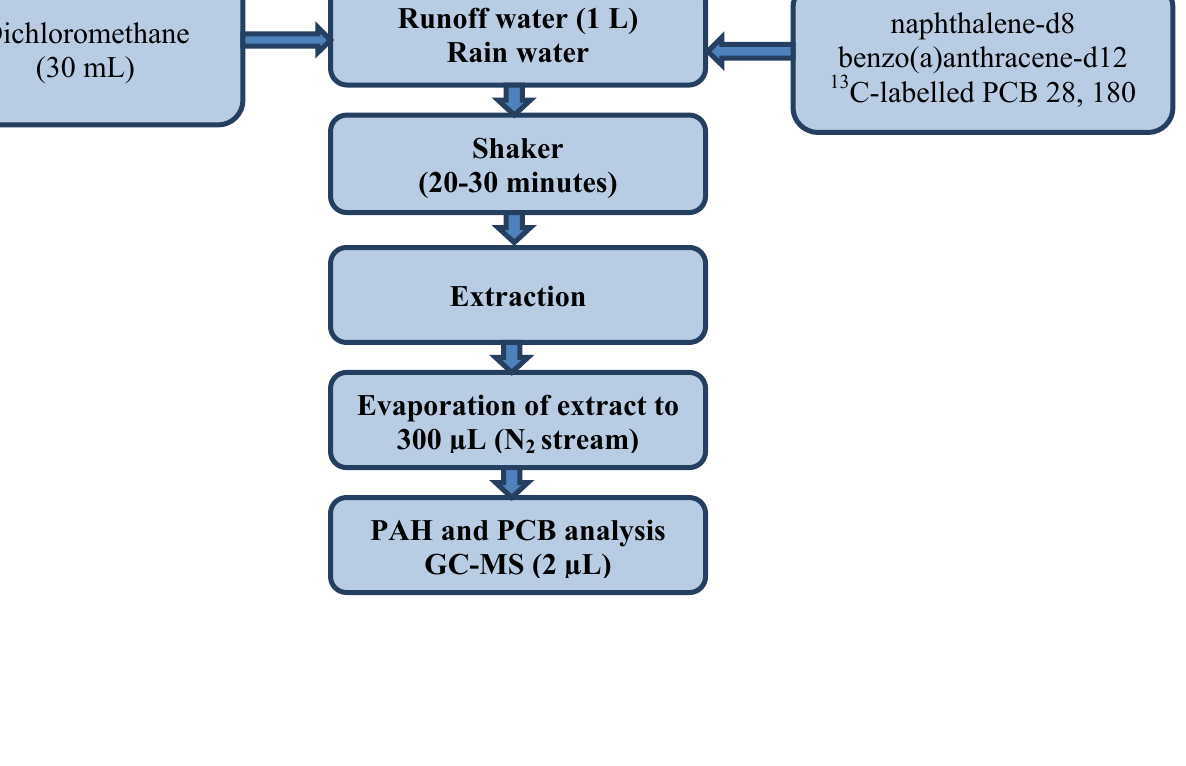
Figure 2. Flow chart of the procedure for preparing runoff water and rain samples for determining their PAH and PCB